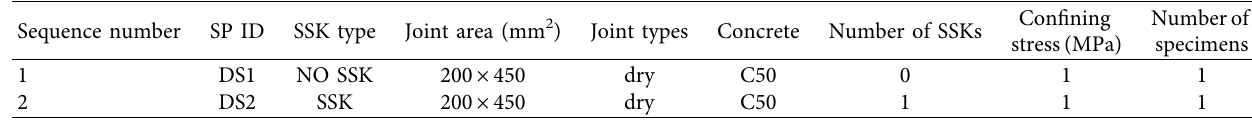
Figure 3: Geometric dimensions of specimen (unit: mm). Table 1: Identification of the specimens and parameters.